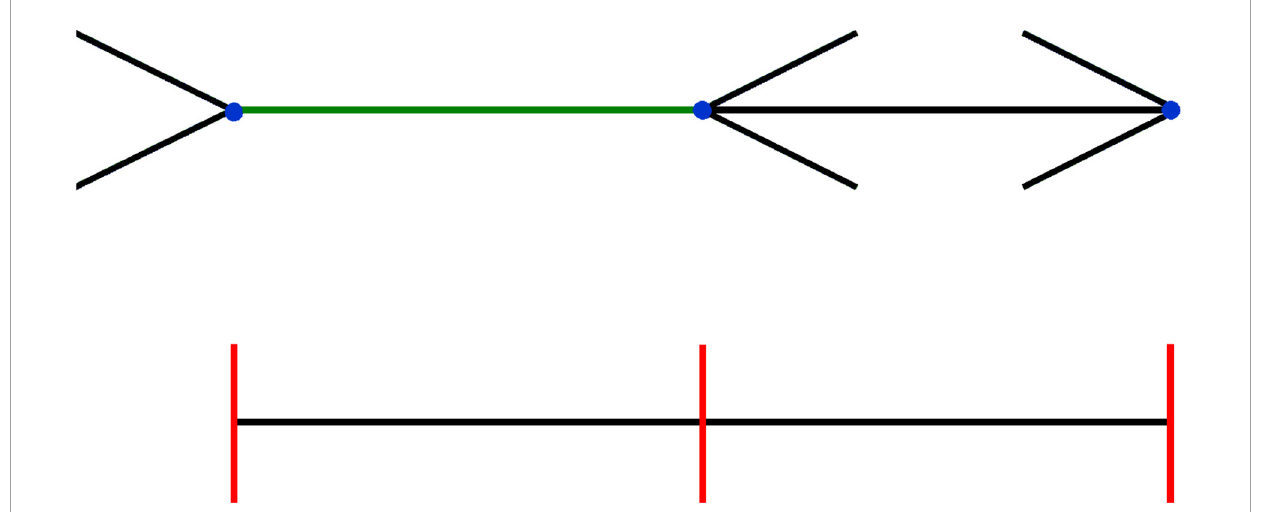
FIGURE4 Inconsistency between size and position in the Brentano version of the Müller-Lyer illusion. The three red lines are (and appear to be) equidistant, and are clearly aligned with the blue dots, which are thus also equidistant. Nevertheless, the green line connecting the two dots on the left seems longer than the black line connecting the dots on the right. When the orientation of the arrows is flipped (see Supplementary Video 2 ), the length of the green line appears to change, while the blue dots seem to remain static.